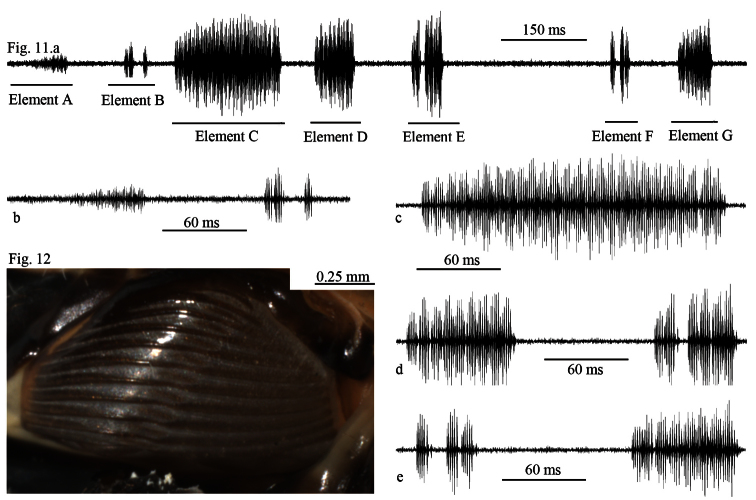
11
Cicadatra platyptera, male alarm song, a 1 phrase (scale=150 ms) b element A and B (scale = 60 ms) c element C (scale=60 ms) d element D and E (scale=60 ms) e element F and G (scale = 60 ms) 12Cicadatra platyptera, right male timbal (scale=0.25 mm).